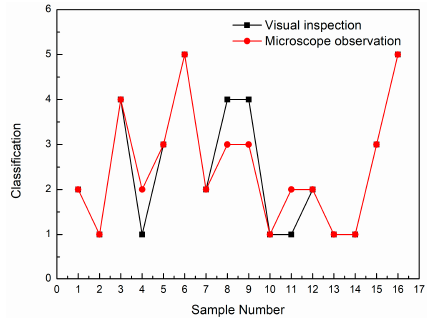
Figure 6. Classification results evaluated by visual inspection and microscope observation, respectively, according to ISO 2409. For No. 4, 8, 9, and 11 samples, different classification is obtained due to different inspection.